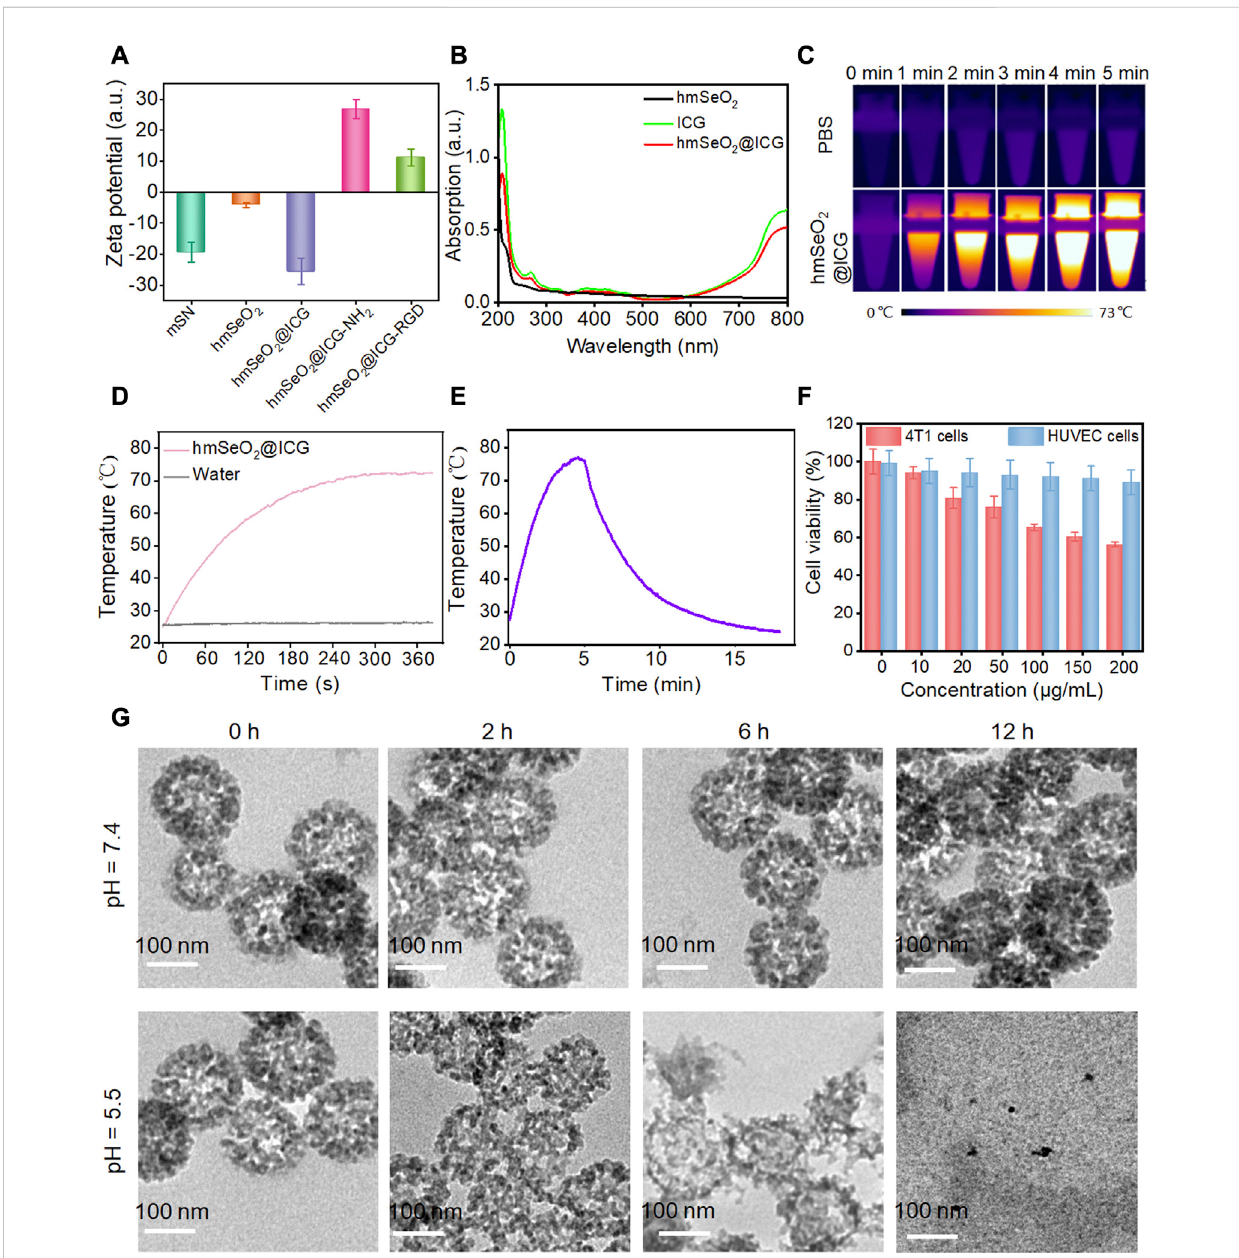
FIGURE 3 (A) Zeta potential values of mSN, hmSeO 2 , hmSeO 2 @ICG, hmSeO 2 @ICG-NH 2 , and hmSeO 2 @ICG-RGD. (B) UV-vis spectra of hmSeO 2 , ICG, and